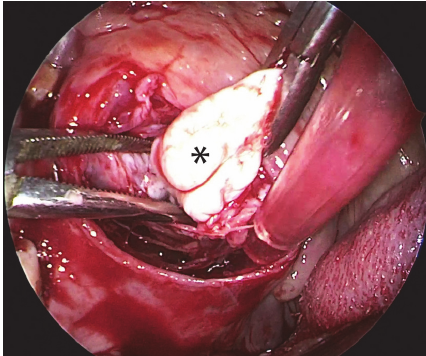
Figure 4: Endoscopic view of tumor being dissected out at V3 as illustrated by broken white